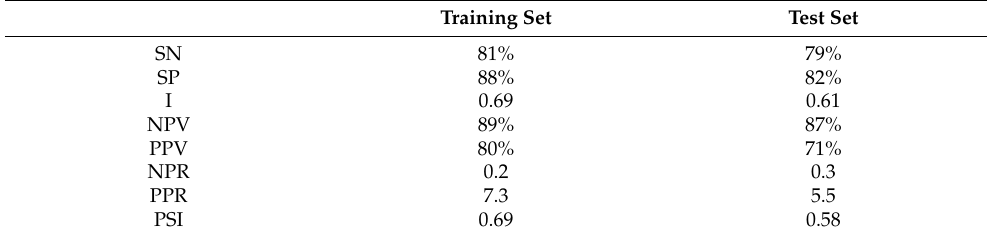
Table 3. Support vector machine (SVM) classifier performance for microvascular invasion (MVI) diagnosis in training and test sets.